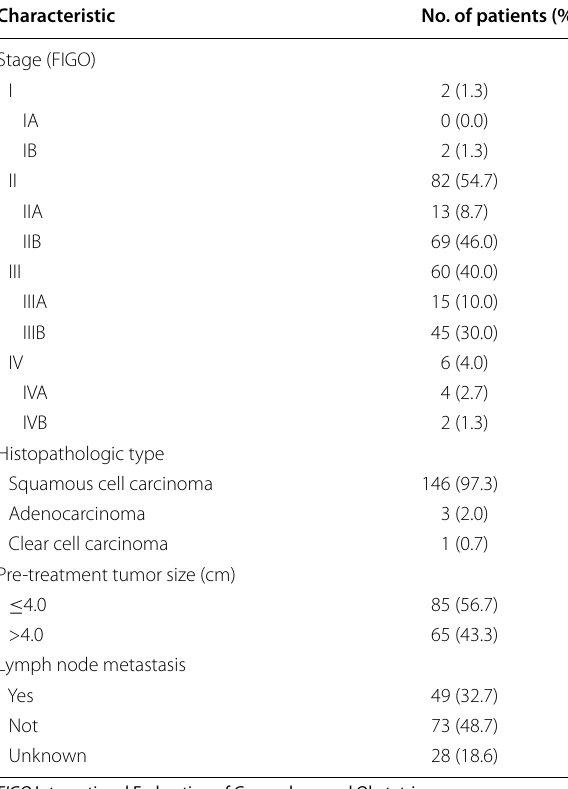
FIGO International Federation of Gynecology and Obstetrics